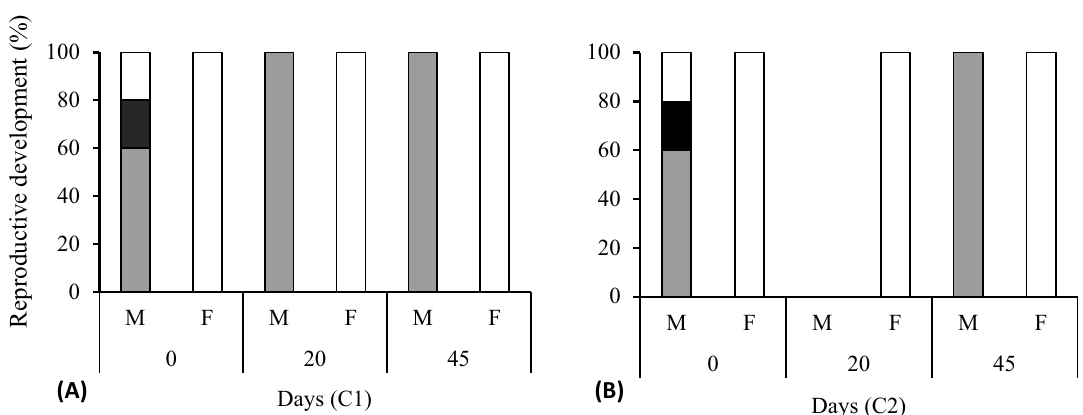
Figure 3. Reproductive development of the Pacific oyster C. gigas during 45 days of pre-conditioning in two experimental conditions. ( A ) Recirculating aquaculture system (RAS) without calcium reactor (control), C1, and ( B ) RAS with the calcium reactor, C2. Black bars, ripe; gray bars, developing-early active, and white bars, resorption. M male, and F female. Reproduction development was evaluated on days 0, 20, and